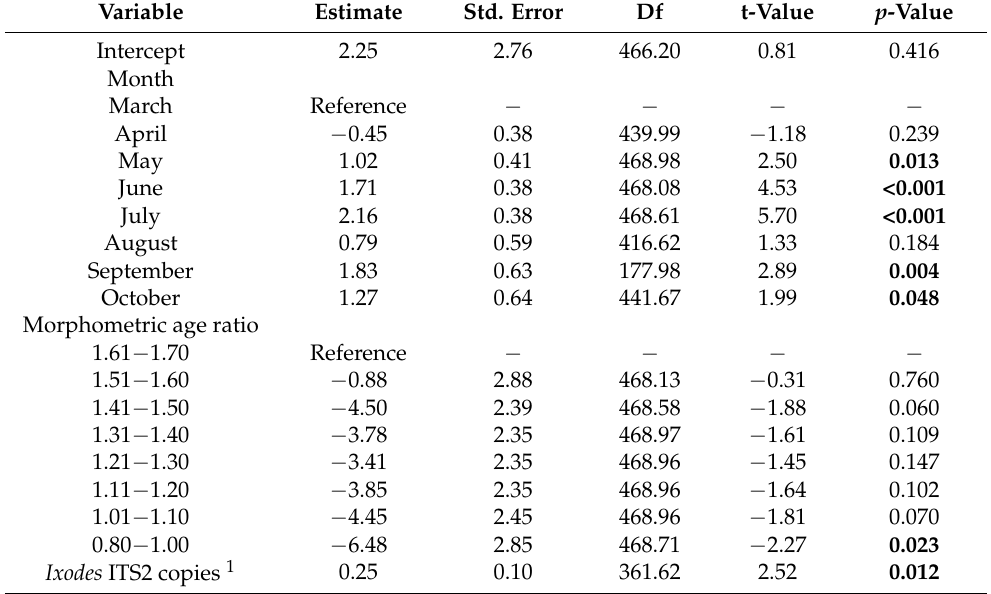
Table 5. Results of the LMM investigating the effects of different variables on log-transformed Borrelia 5S–23S IGS copy numbers among 485 Borrelia -positive ticks. The full model was significantly different from a null model containing only the random factor ( χ 2 = 91.82, Df = 15, p < 0.001). Significant p -values ( ≤ 0.050) are shown in bold. Variable Estimate Std. Error Df Intercept March